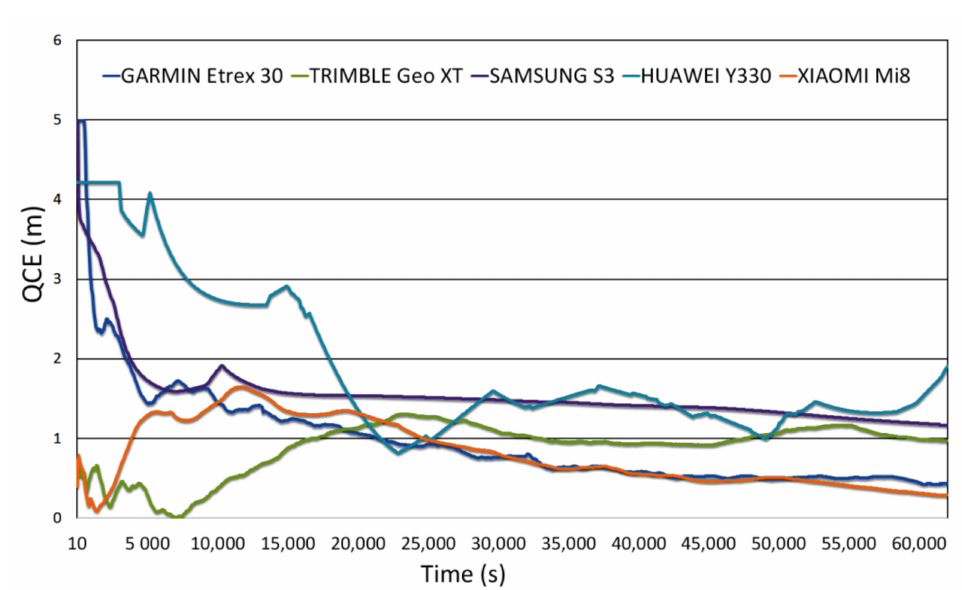
Figure 2. The relationship between the time and the quadratic composition of the East and North errors (QCE) of each device. From 10 to 60,000 s period of recorded data. East and North errors are the differences between the control point and coordinate means.